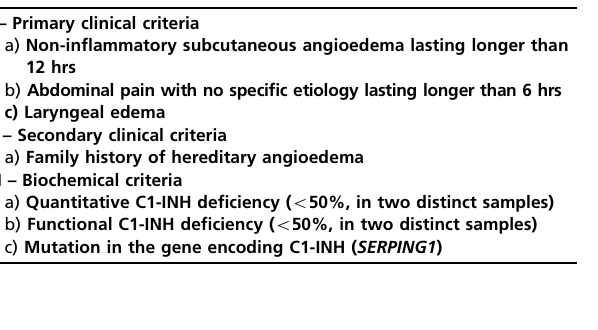
Table 1 - Diagnostic Criteria for Hereditary Angioedema with C1-INH Deficiency (12,26).